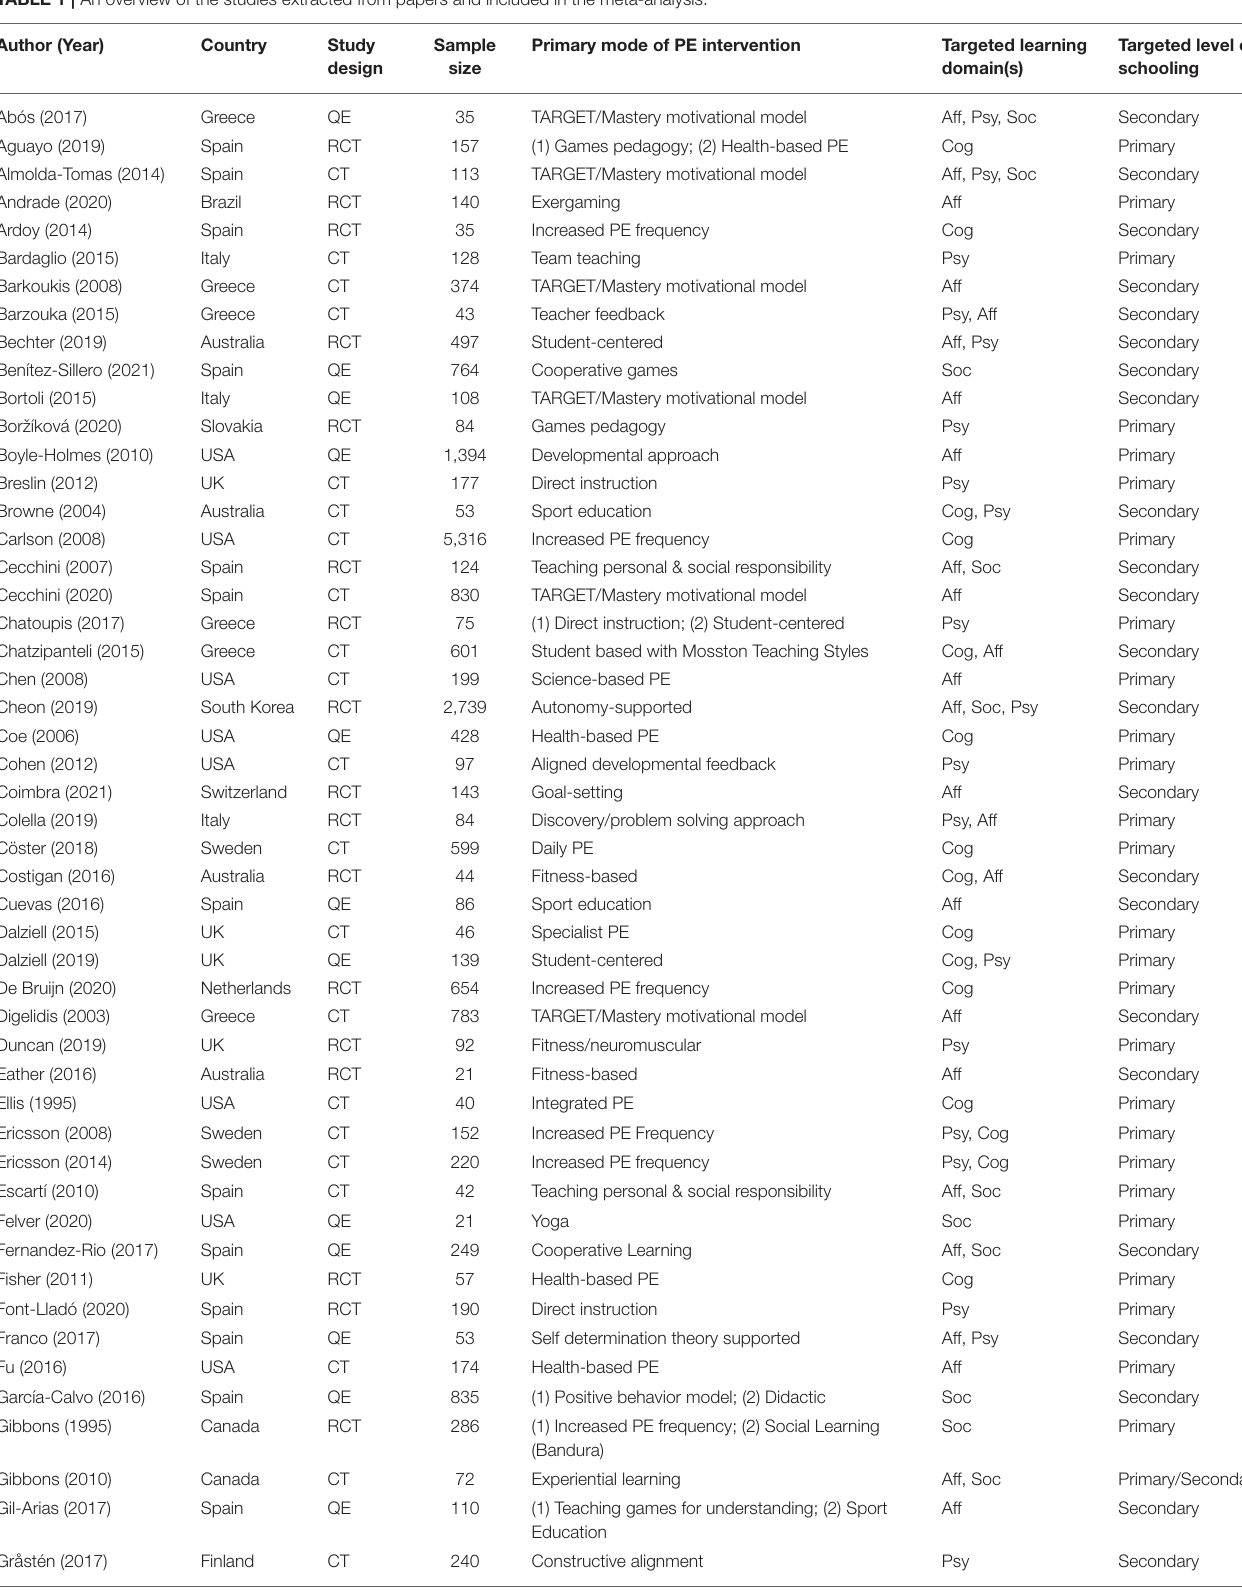
TABLE 1 | An overview of the studies extracted from papers and included in the